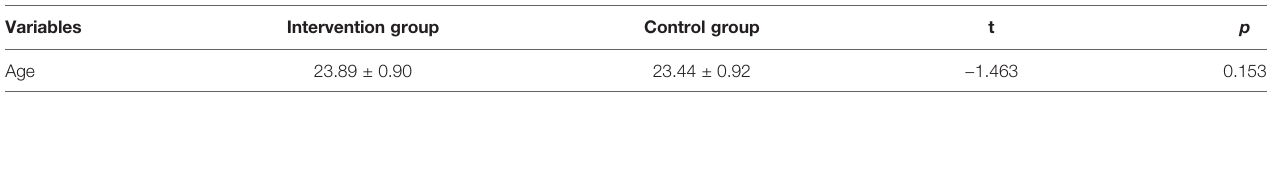
TABLE 1 | Comparison of age between the intervention and the control group ( x ± s ).